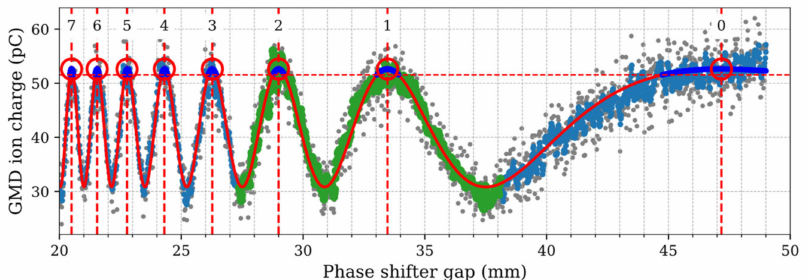
Figure 9. The measured FEL intensity (GMD ion current) as a function of the gap of the phase-shifter No. 6 at the soft X-ray FEL line. The undulator K is 2.2529. The solid red line represents the fitting of the data. The intensity peaks are marked with a red circle and their corresponding phase number. The thick bule line at peaks represents the span of the ± 5% decrease in the peak FEL